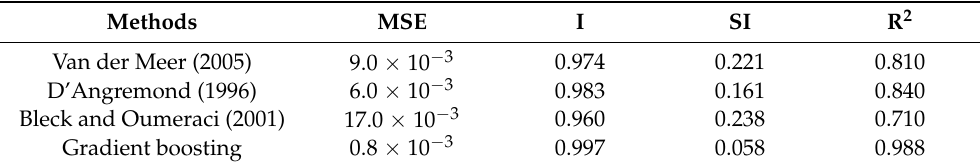
Figure 9. Comparison of predictive performance of empirical formulas and machine learning model. ( a ): Comparison of wave transmission formulas (Van der Meer) with experimental data. ( b ) Comparison of wave transmission formulas (D’Angremond) with experimental data. ( c ) Comparison of wave transmission formulas (Bleck and Oumeraci) with experimental data. ( d ) Comparison of GBR model with experimental data. Table 6. Statistical parameters of the Table A1. The indication of the range of the parameters.